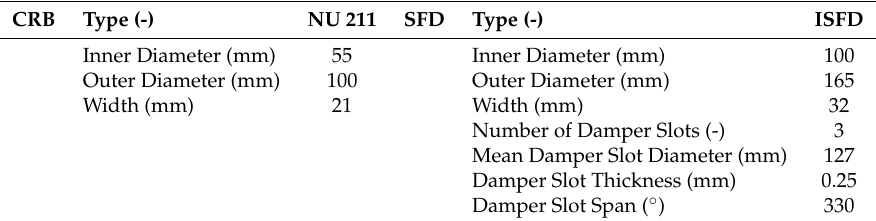
Table 2. Geometric properties of the rotor